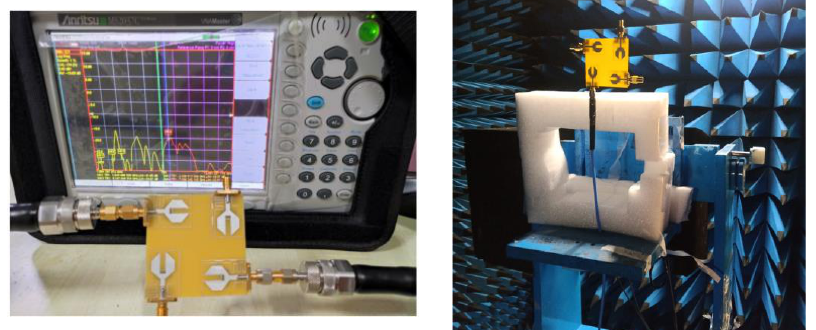
Figure 11. Proposed MIMO antenna prototype.